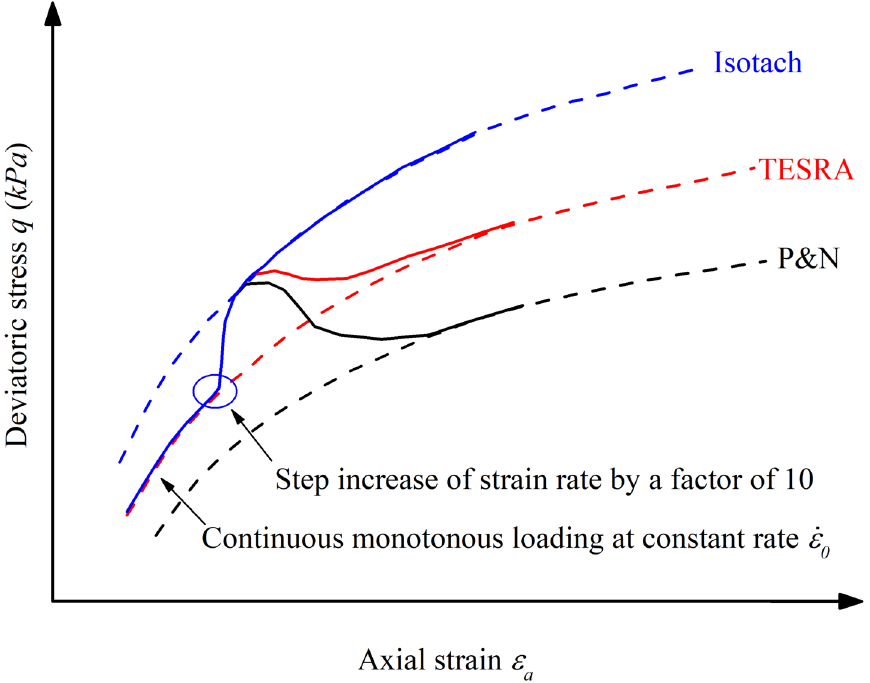
Figure 5. Illustration of common granular viscosity types in sand or other granular materials, namely Isotach, TESRA and